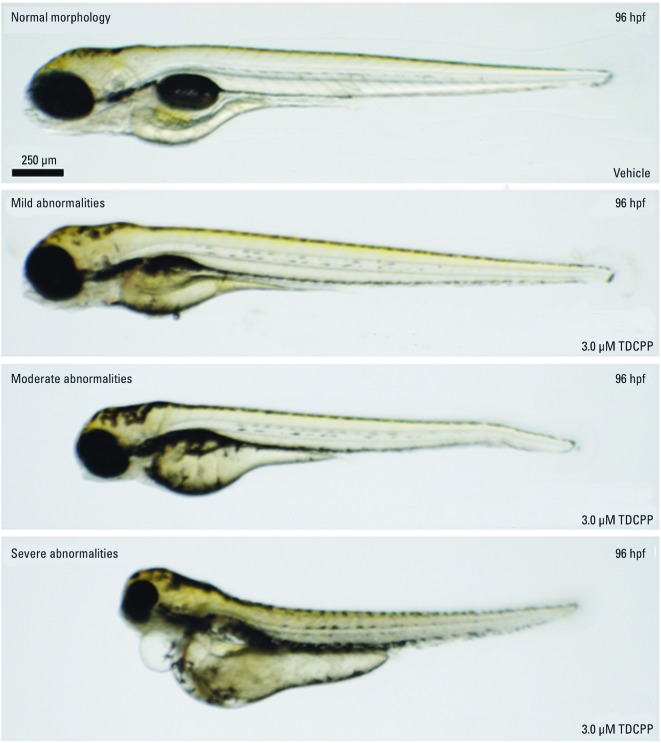
Effect of TDCPP exposure on embryonic phenotypes. Zebrafish embryos were treated with vehicle (0.1% DMSO) or 3 μM TDCPP from 0.75 hpf (2‑cell) to 96 hpf and assessed for gross malformations under transmitted light at 96 hpf. Images are representative of within-treatment phenotypes observed within surviving larvae after developmental TDCPP exposure. Mild = trunk curvature and/or tail malformations; moderate = trunk curvature, tail malformations, craniofacial malformations, and decreased body length; severe = trunk curvature, tail malformations, craniofacial malformations, decreased body length, pericardial edema, and yolk sac edema.